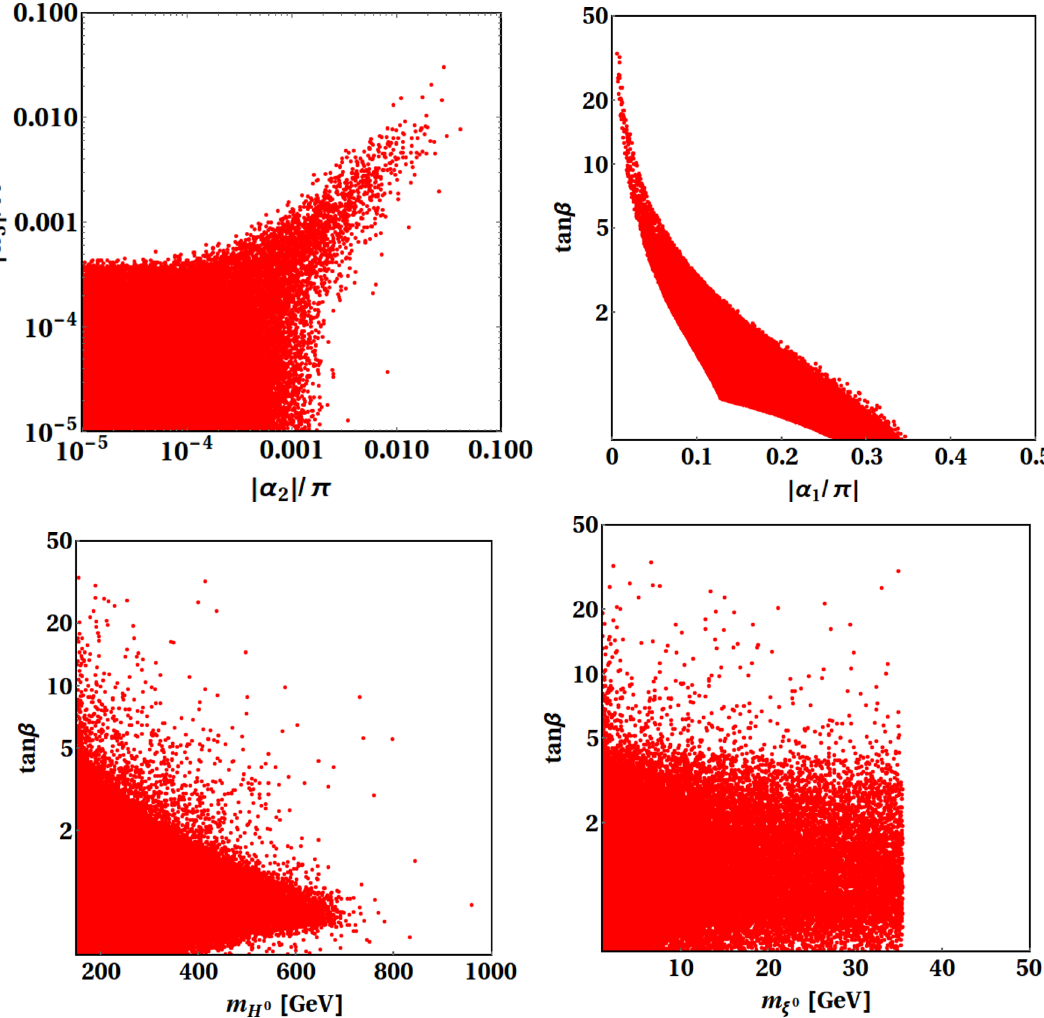
Figure 3 . The allowed parameter regions satisfying constraints from scalar potential and Higgs